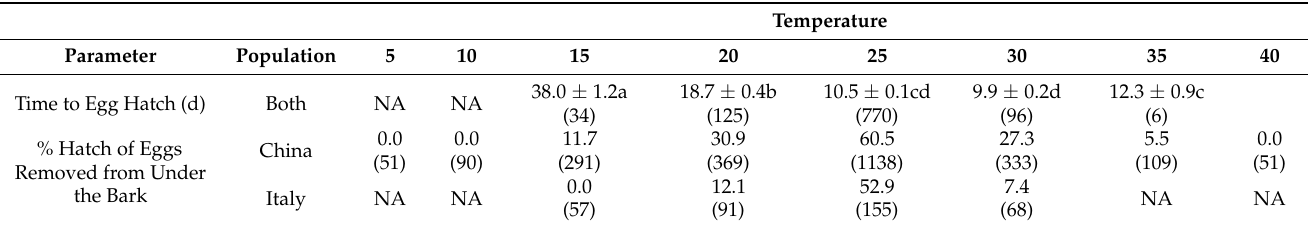
Table 3. Effects of temperature on Anoplophora chinensis egg hatch (mean ± SE (n)).